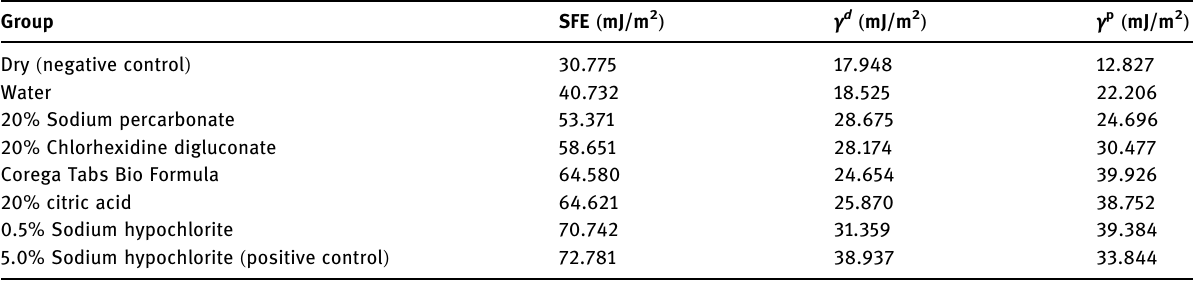
Table 9: SFE and its components of Co – Cr alloy after immersion in di ff erent denture cleaners